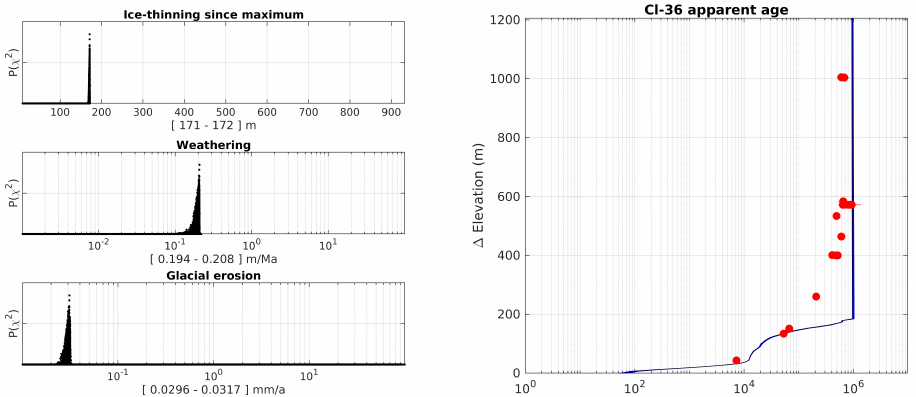
Figure 5. Marble Hills NUNAIT results using fit type 1 . A reduced chi-squared value of 23 was obtained for the best fitting model. Note that when using fit type 1 , models producing apparent exposure ages shorter than sample data are discarded. This results in no data being shown above a certain threshold in the first two graphs on the left column (ice-thinning and weathering